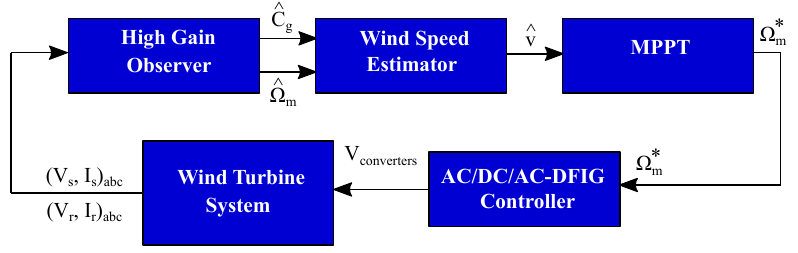
Figure 4. Structure of the sensorless MPPT.